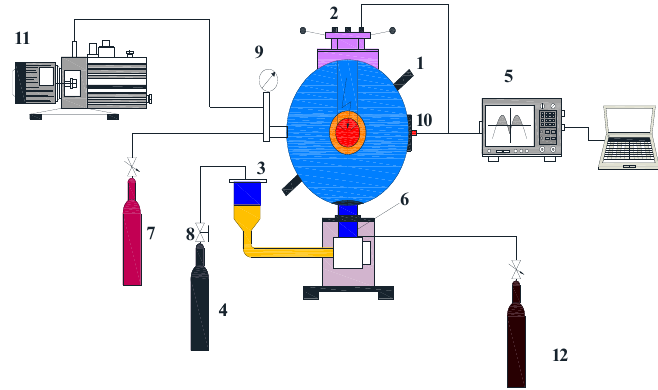
Figure 1. The illustration of 20 L spherical explosion system.